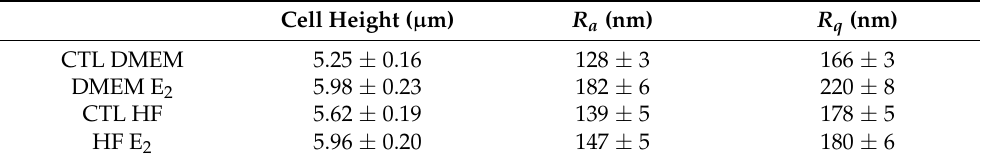
Table 2. Mean values ± SE of cell height, average roughness and root mean square roughness determined from AFM contact mode height images. At least 25 cells were evaluated per